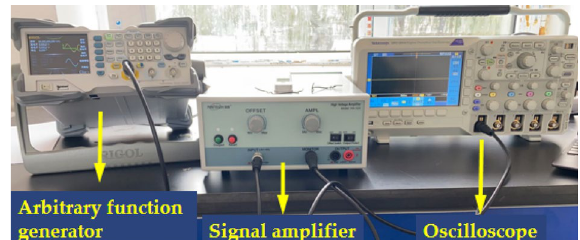
Figure 1. Coal crack monitoring system based on PZT sensor.